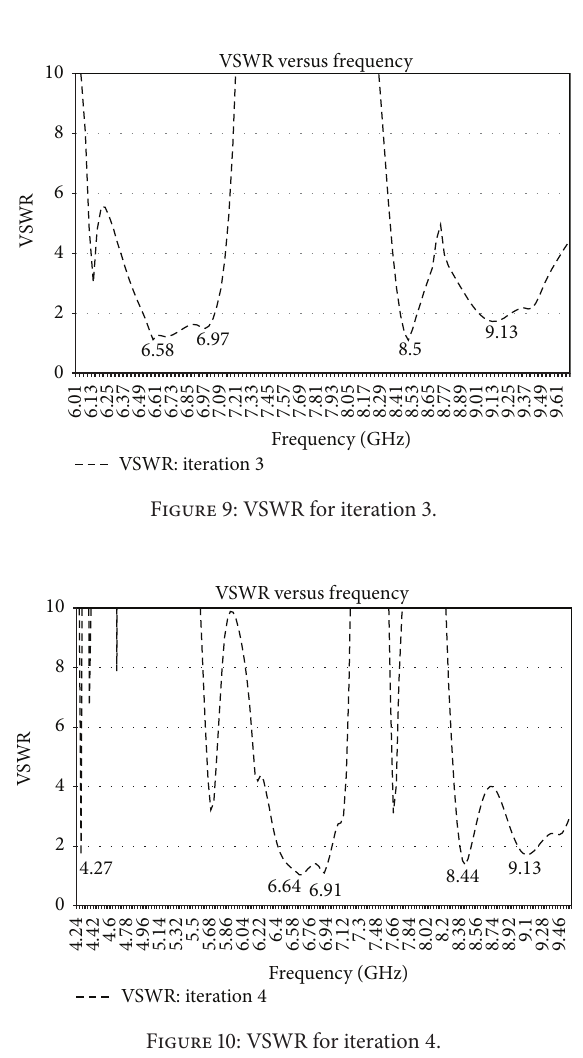
reflection coefficient graphs. The VSWR dips below 2 for the corresponding resonating frequency.